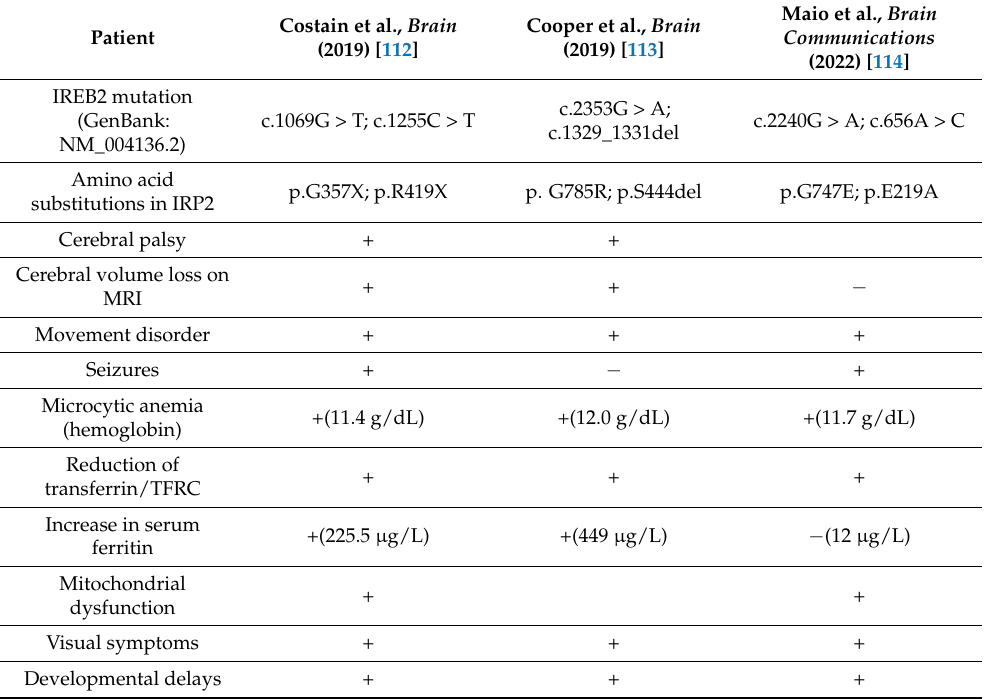
Table 1. Summary of IRP2-null patients’